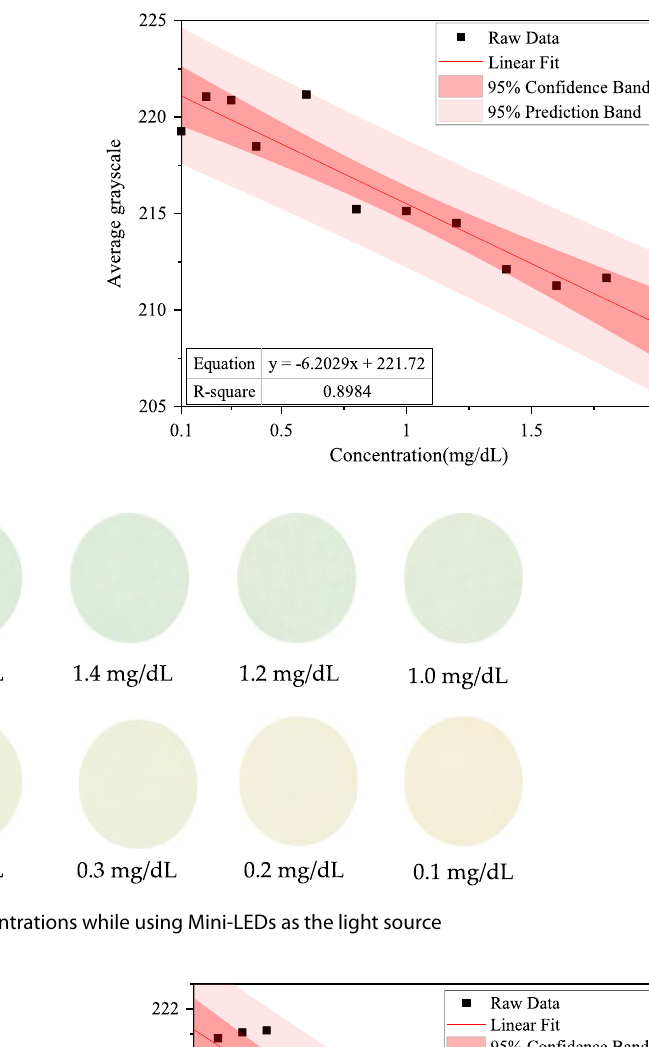
Fig. 9 Linear relationship between different concentra- tions of direct bilirubin and average grayscale of the G channel while using an H2 lamp as the light source